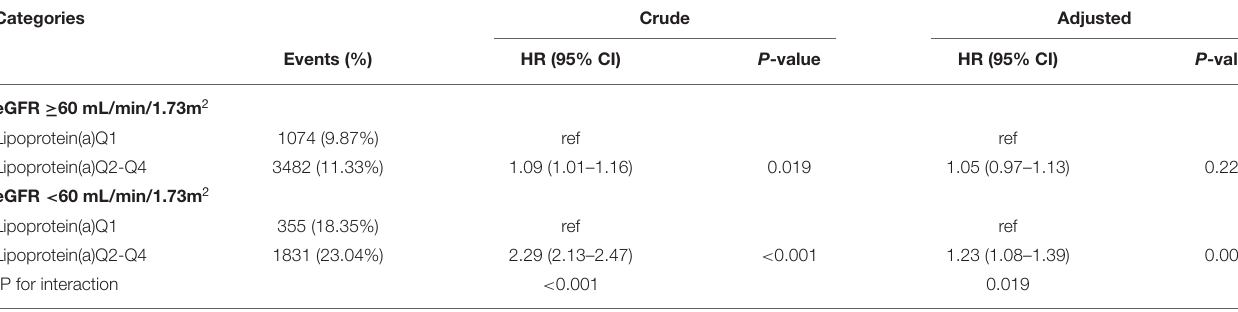
TABLE 3 | HR of all-cause mortality across lipoprotein(a) categories in eGFR ≥ 60 mL/min/1.73m 2 and eGFR < 60 mL/min/1.73m 2